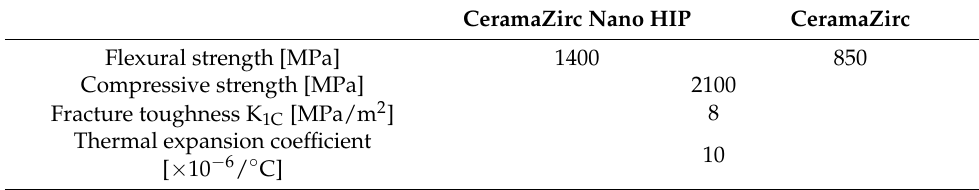
Table 1. -Commercial names and properties of the tested